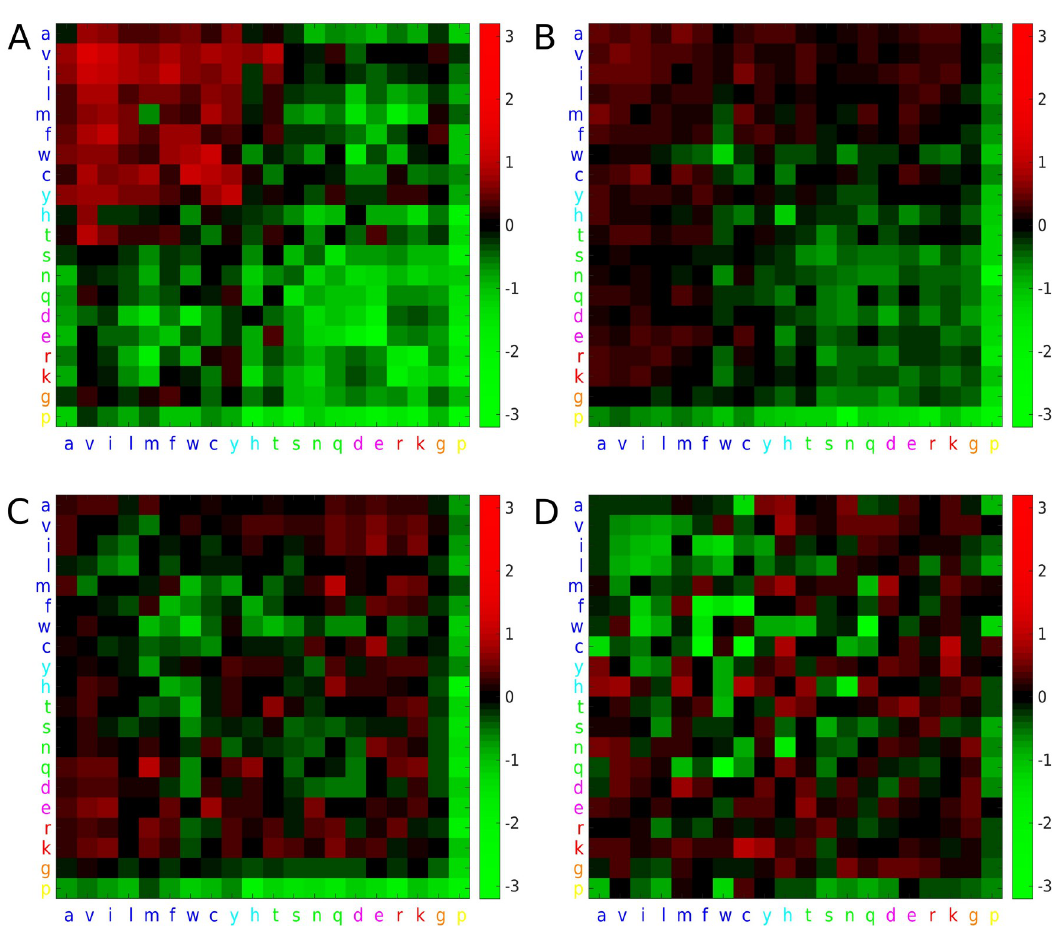
Fig 5. The propensity of correctly predicted contact pairs to be of a given residue type in a given distance bin range. A: 0-8 Å , B: 8-13 Å C: 13-18 Å D: 18-23 Å . Coloured squares represent log 2 ( < O/E > ) as shown on the right hand scale. Single letter amino acid codes are coloured according to the default ClustalX colouring scheme, i.e. hydrophobic as dark blue; tyrosine and histidine in cyan; non-charged polar amino acids in green; acidic residues as magenta; basic aliphatic residues as red; glycine: orange; proline: